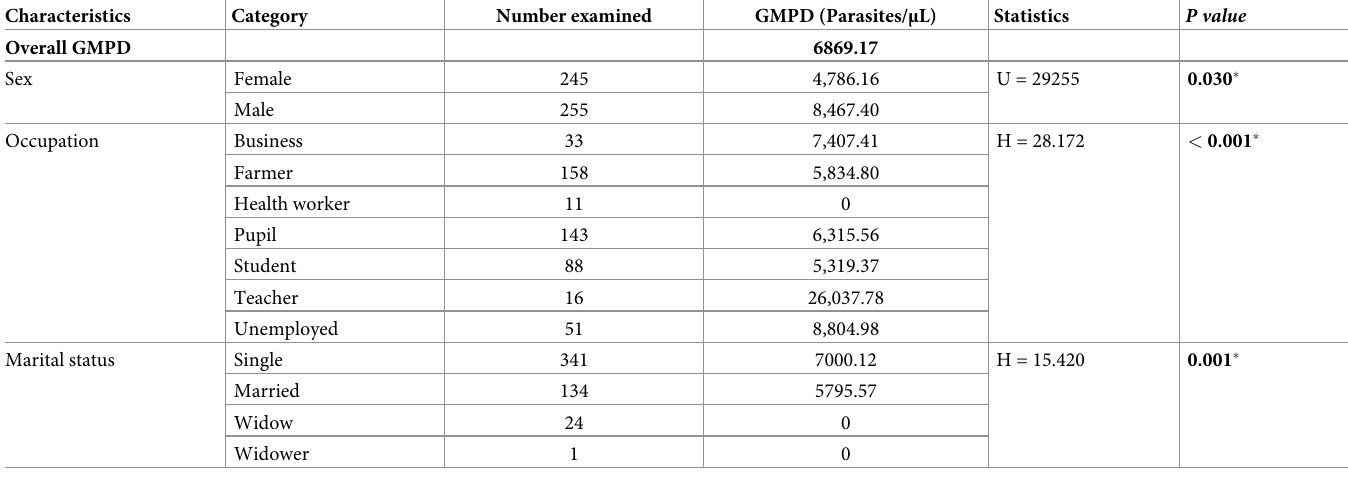
Table 5. Geometric mean parasite density of malaria with respect to demographic factors.